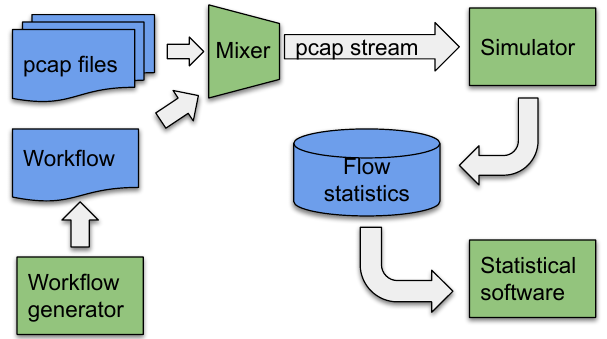
Figure 5. Schematic of a simulation